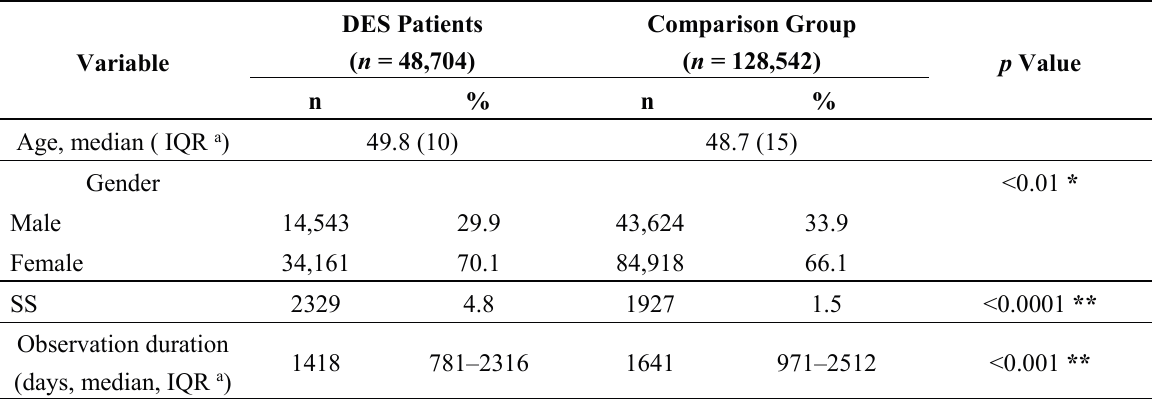
Table 1. Comparison of dry eye syndrome (DES) and comparison groups concerning later development of Sjögren’s syndrome (SS) with respect to characteristic demographics.